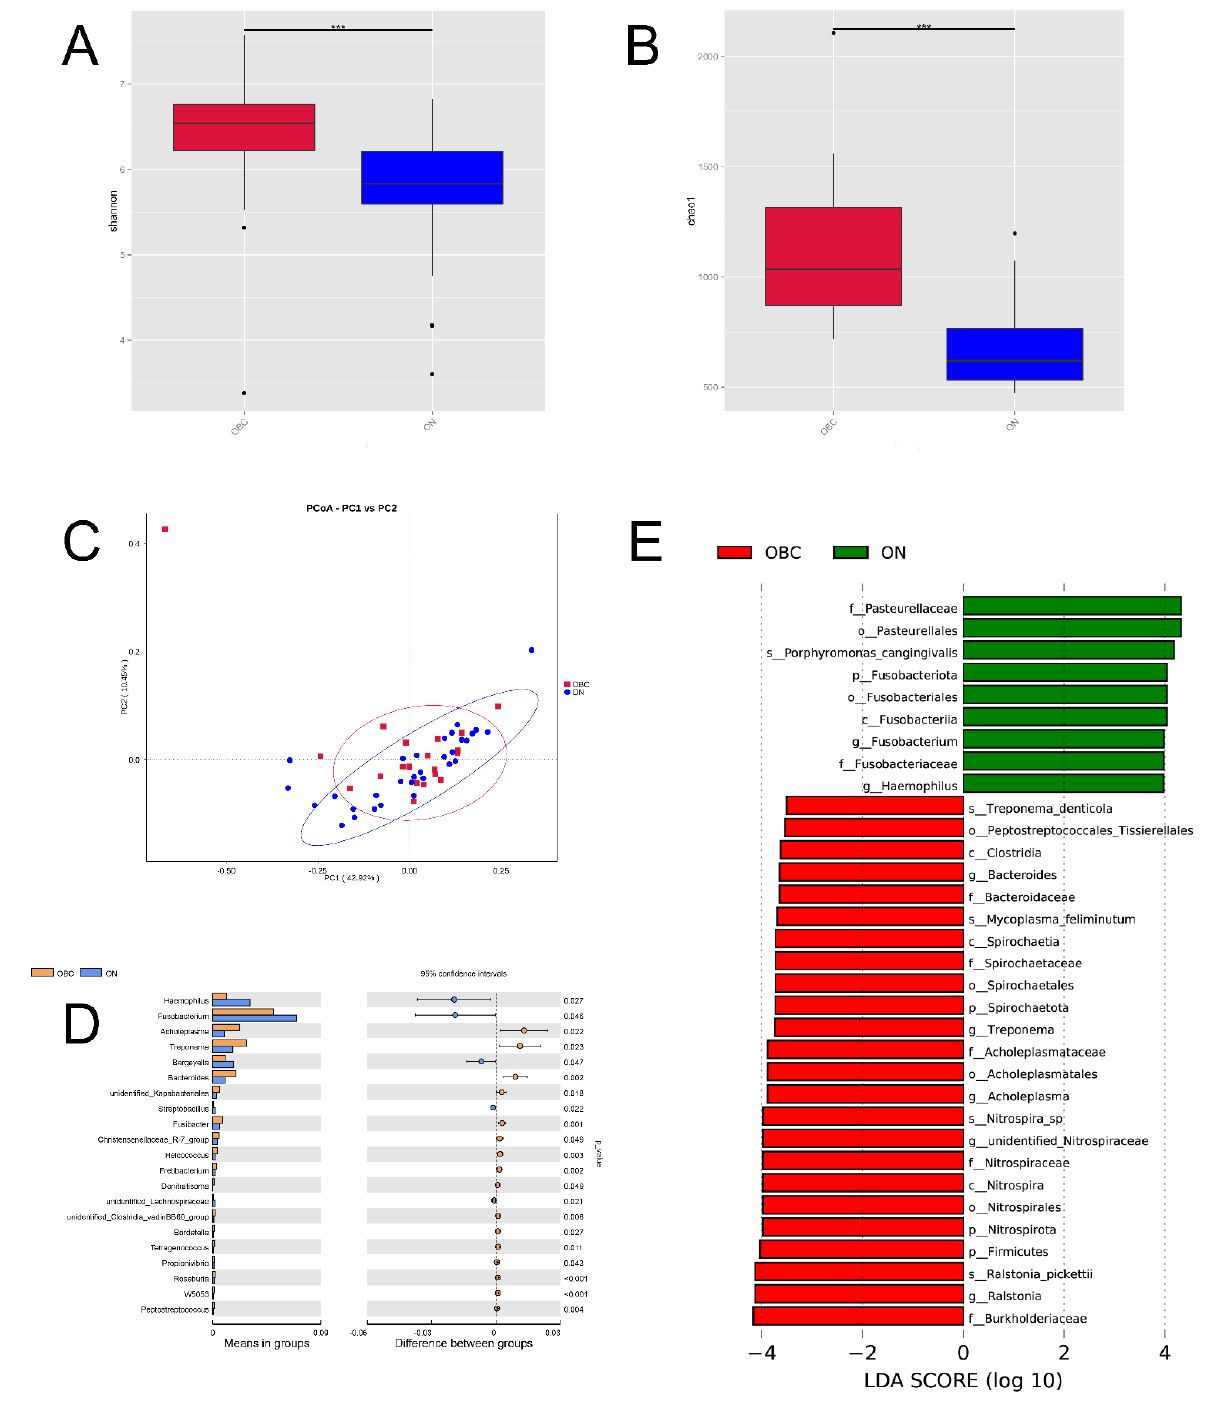
Figure 3. Oral microbial composition and diversity in dogs with canine mammary tumors (OBC group) and healthy dogs (ONN group). ( A , B ) Alpha diversity (Shannon and Chao1 index) of microbial communities between both CMT and CAT groups: two mean values of the OBC group were both higher than that of the ONN group; ( C ) Beta diversity (the weighted UniFrac analysis) of microbial community structures between both OBC and ONN groups: it depicted the distance relationship between both two groups; ( D ) The oral microorganisms which had significantly different abundance in the OBC and ONN groups at genus level; ( E ) The LDA Effect Size (LEfSe) of OBC and ONN groups: it exhibited the remarkable bacteria of oral microbiota that characterizes the differences between both two groups. Statistically significant differences ( p < 0.01) are indicated by